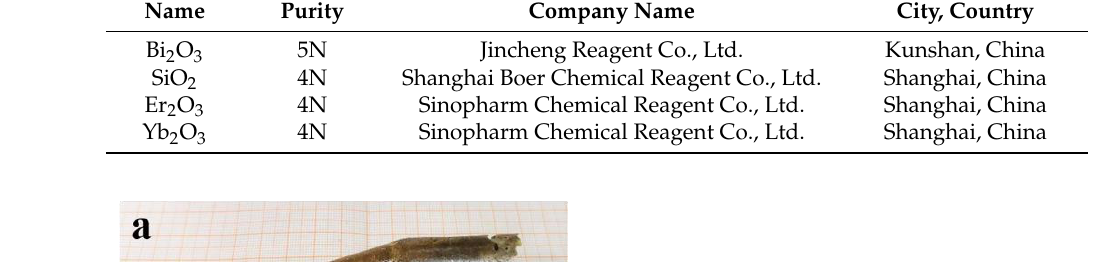
Figure 1. As-grown ( a ) pure BSO, ( b ) Er: BSO, and ( c ) Er/Yb: BSO crystals.